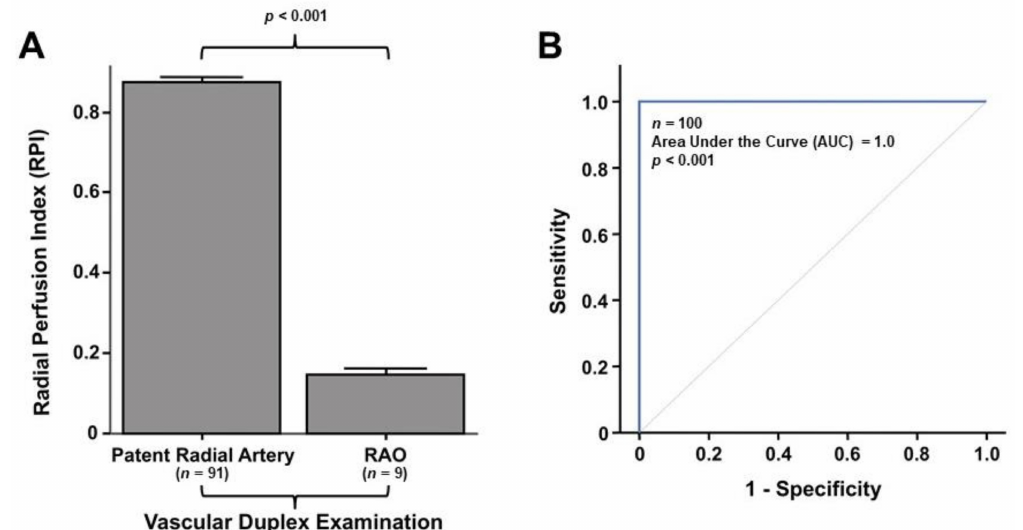
Figure 3. Post-procedural measurement and diagnostic performance of the Radial Perfusion Index (RPI) for diagnosis of RAO. ( A ) The error bars depict the mean RPI measured 24–48 h after the procedure in patients with patent Radial Artery (left) and in patients with RAO (right). ( B ) ROC analysis showed an excellent diagnostic performance of the LPI in the present study, with an Area under the Curve (AUC) of 1.